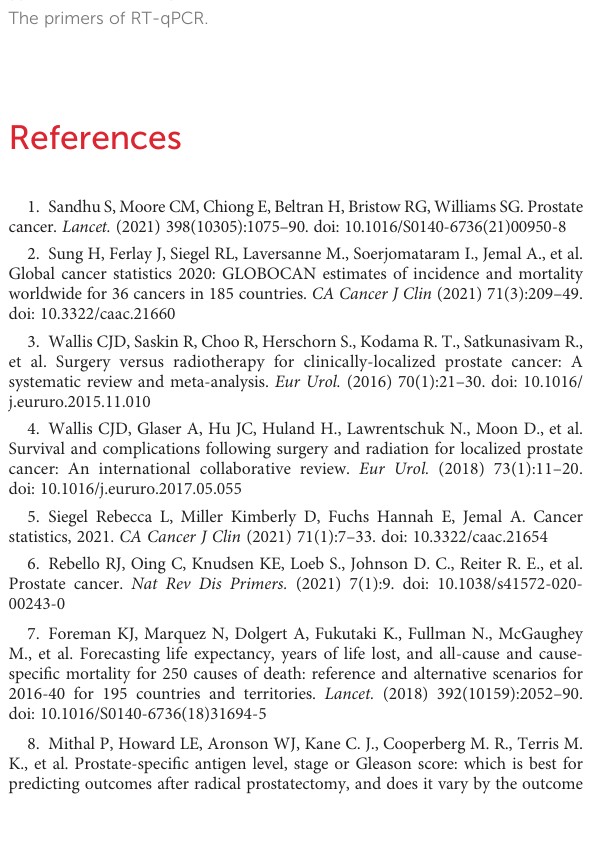
sequencing data. SUPPLEMENTARY FIGURES 5 Using Copykat to identify malignant epithelial cells. SUPPLEMENTARY FIGURESA 6 Dotplot of GO enrichment